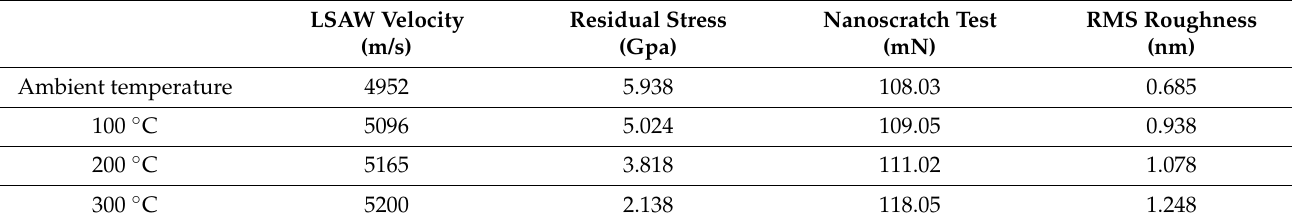
Table 4. Overall results of the TiN thin film measurement